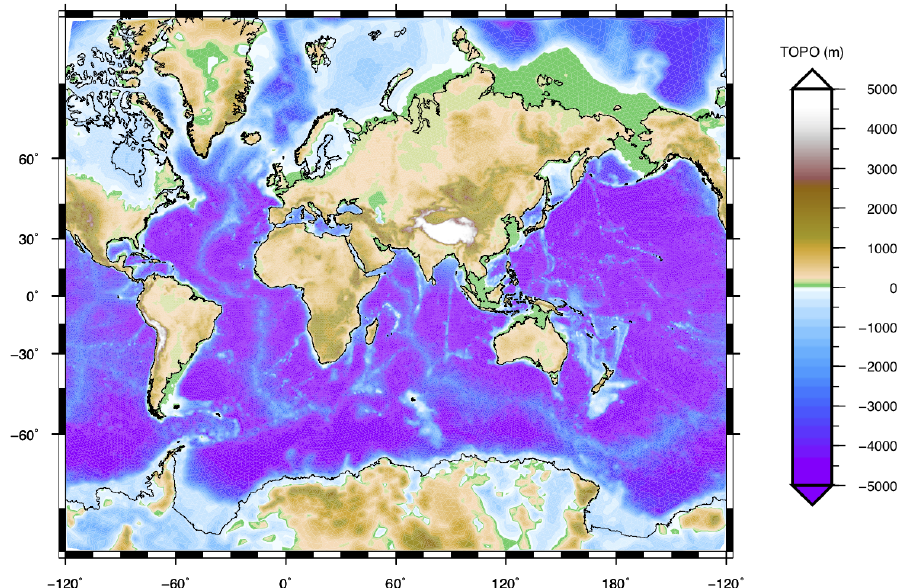
Figure 5. Sample SELEN 4 output of the global relief at the LGM (21ka), according to the test run with R44/L128/I3 , where topography ETO-R44 of Fig. 2 has been used as a final condition for the SLE.